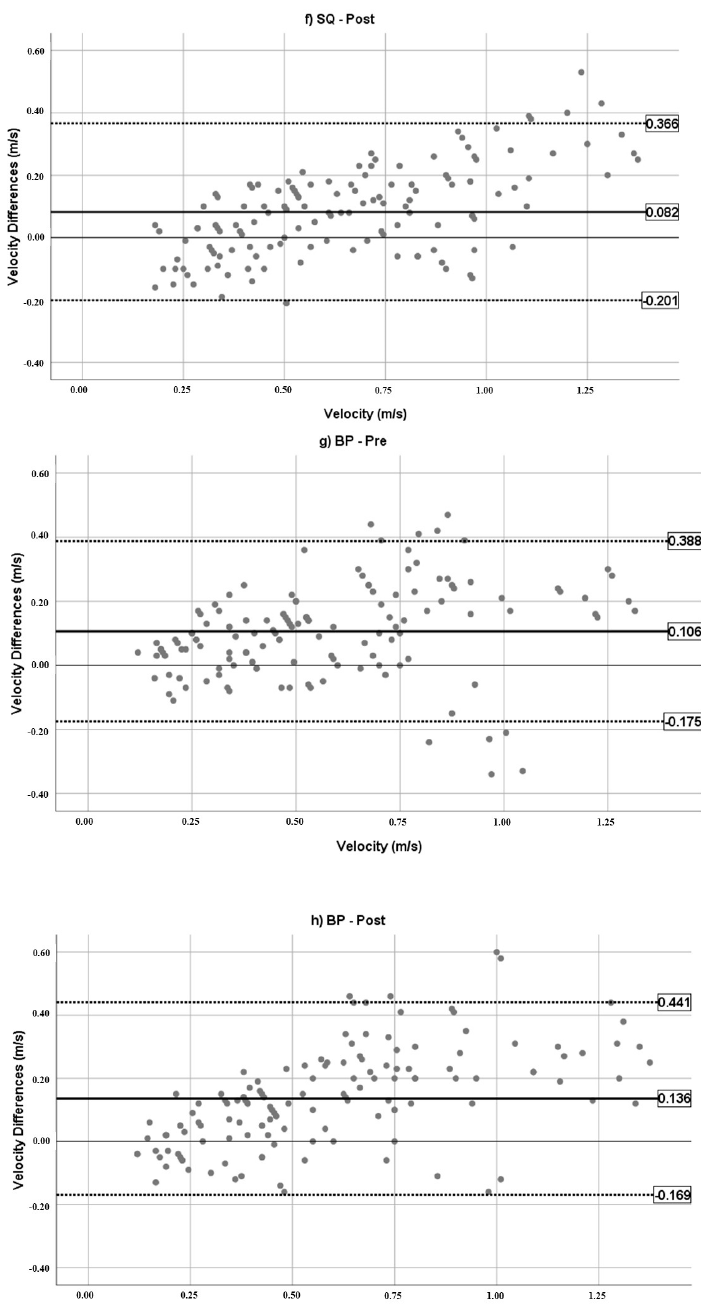
Figure 1. Bland–Altman plots for the agreement between real and perceived velocities. Experimental group: ( a ) SQ Pre; ( b ) SQ Post; ( c ) BP Pre; ( d ) BP Post. Control group: ( e ) SQ Pre; ( f ) SQ Post; ( g ) BP Pre; ( h ) BP Post.